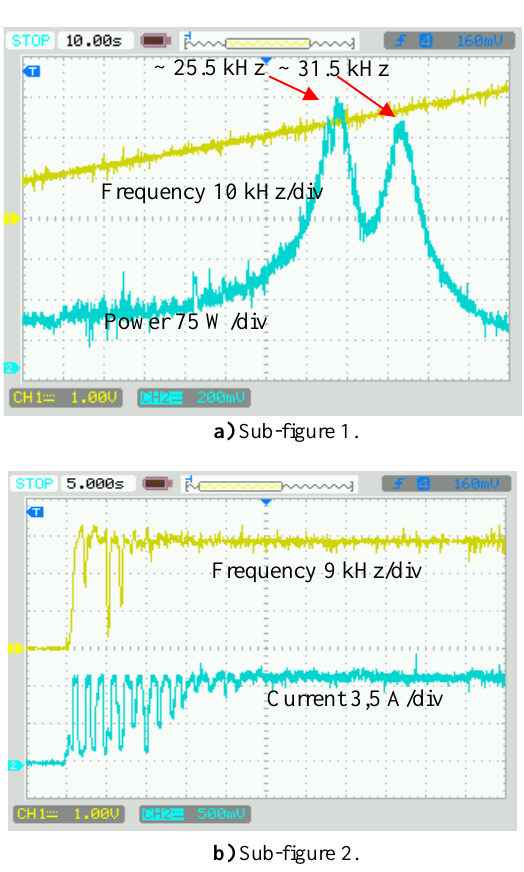
Figure 9. Oscilloscope screenshot for Scenario II for scanning for input power to the primary side resonant coupler (a) and the inverter’s switching frequency and performance of PSO algorithm (b).